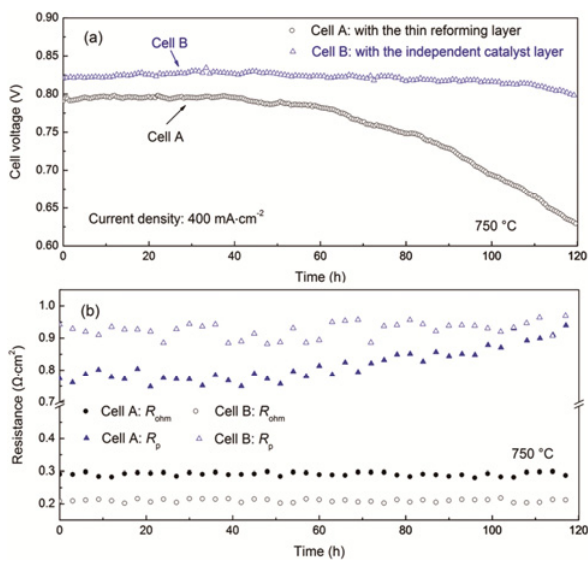
Fig. 8 Performance stability of single cells in methanol at 750 ℃ : (a) variations in cell voltage at 400 mA·cm − 2 and (b) R ohm and R P of single cells.